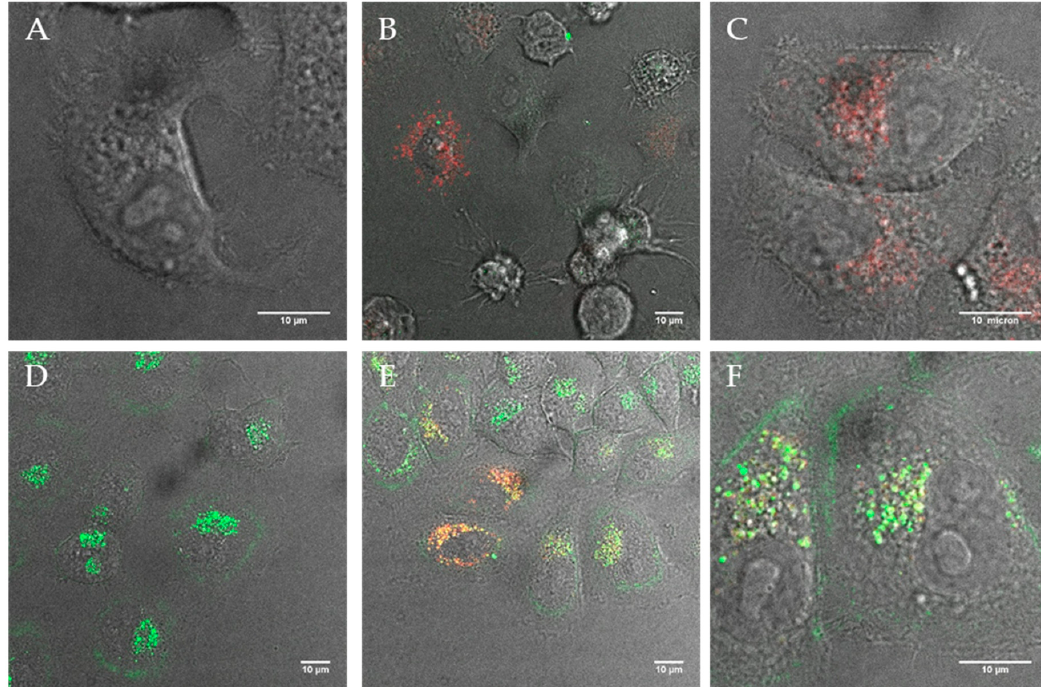
Figure 3. Confocal images of ( A ) HeLa cells after 12 h incubation with polymersomes containing 40% DEDETA (1 % DEAC; green) and ( B + C ) the corresponding lysosome (red) co-localization images; Image ( D ) shows HeLa after 12 h uptake with 20% DOEPC-blended lipopolymersomes (green) and ( E + F ) show the co-localization within lysosomes (red).